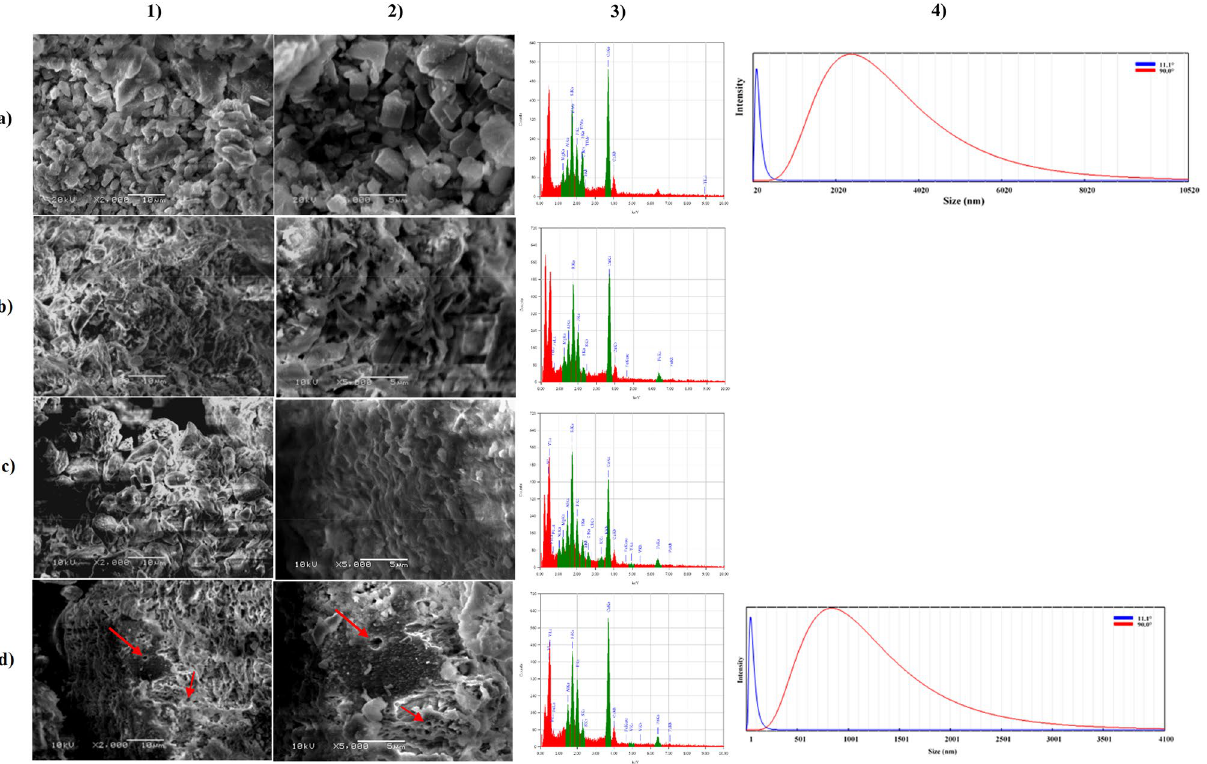
Figure 9. Scanning electron microscopy (SEM) micrograph of the rock phosphate leftover samples, ( a) at zero incubation time, ( b) after 12 h of incubation time, ( c) after 24 h of incubation time, and ( d) after 32 h of incubation time at a magnification 1) 2000 x, and 2) 5000 × with 15 kV, 3) EDX analysis chart, and 4) particle size distributions analysis (AT% of 16.99 and mass% of 12.44), and P (AT% of 10.93 and mass% of 8.83) are the most abundant in the sample. Thus, the Ca:P weight ratio of the RP hydroxyapatite was 4.805. In addition, Bachouâ et al. 30 observed irregular forms of Tunisian rock particles alongside the presence of Ca, P, O, Si, C, and F, which are different in metals content from that present in Egyptian RP particles and exploited in the current investigation. On another side, after 12 h from fermentation time, as shown in Fig. 9b1,b2, the bacteria formed a rugged structure on the RP particle’s surface. As a result of bacterial growth, RP morphology has altered, with parti- cles taking on looser structure, irregular shapes, and polygonal shapes vanishing with a blurring of the surface boundaries of the granules. Meanwhile, EDX analysis revealed that the Fe appeared in small traces together with S, Al, and Mg, accompanied by the disappearance of Ti. However, Ca (AT% of 44.96 and mass% of 50.04), Si (AT% of 20.39 and mass% of 15.90), and P (AT% of 11.5 and mass% of 9.9), are still the major elements in the sample as illustrated in Fig. 9b3. It was observed that the AT% for Ca was decreased by factor 0.85 as a result of bacterial cell consumption. At the same time, about 20 and 30.3%, a noticeable elevation in AT% for Si and P was noted, respectively. This elevation is because the solubilization process carried out by B. haynesii strain ACP1 led to releasing such metals from RP. As a consequence, the Ca:P weight ratio of the RP hydroxyapatite was 3.909, which was lower than the obtained ratio before the fermentation process by 18.63%. In Fig. 9c1,c2, the RP particle form disappeared, and tiny pores seemed to result from bacterial cell growth and its metabolites effects. Additionally, more extra elements were detected through EDS analysis after 24 h incubation time like K, Cl, V, and Na along with the above-mentioned elements. However, the most plentiful elements were Ca (AT% of 33.59 and mass% of 38.71), Si (AT% of 21.98 and mass% of 17.74), and P (AT% of 10.32 and mass% of 9.19). It was noticed that about 25.28% and 36% reduction in Ca content (AT%) compared to that obtained at 12 h and zero incubation time, respectively. Only 10.26% less in P content (AT%) than those obtained after 12 h incuba- tion time was observed. As a result, the Ca:P weight ratio of the RP hydroxyapatite was 3.25. About 32.26% and 16.73% reduction in Ca:P weight ratio compared to zero time and after 12 h incubation time, respectively. At the same time, the trend of Si content (AT%) is still grown-up by a factor of 1.077 and 1.29 more than those achieved at 12 h and zero incubation time, respectively (Fig. 9c3). Finally, when compared to the control sample at the end of cultivation time, the treated RP surfaces were significantly eroded by the B. haynesii strain ACP1, and several asymmetrical slots and pits on the RP surface were detected, as illustrated by the red arrow on the RP surface in Fig. 9d1,d2. This erosion might be due to proton assault by B. haynesii strain ACP1 secreted organic acid compounds and phosphate leaching, which was previously observed by Maharana et al. 29 , and Henri et al. 31 . The leftover RP particles had an irregular shape with no sharp edges that were non-uniformly distributed (mono- dispersed) with substantial deformation. Al, S, V, and Fe were recorded as traces by EDS analysis. Ca (AT% of